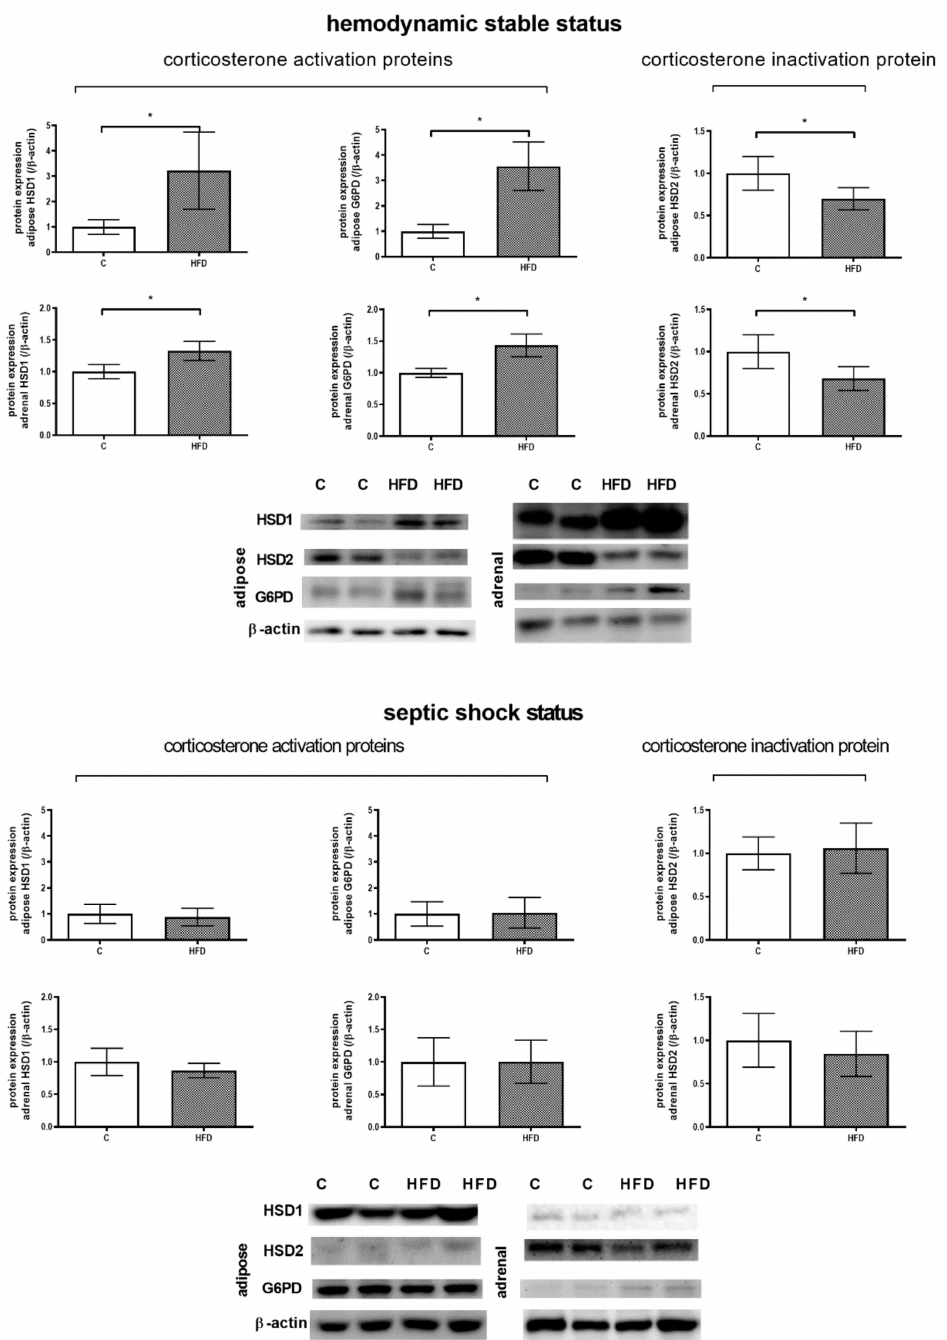
Figure 8. Adipose tissue and adrenal gland 11 β -HSDs system-related proteins expressions. ( A ) 11 β -HSD1, G6PD and 11 β -HSD2 protein expressions in hemodynamic stable condition. In the adipose tissue and adrenal gland, the expressions of 11 β -HSD1 and G6PD increased significantly whereas the expression of 11 β -HSD2 reduced. ( B ) 11 β -HSD1, G6PD and 11 β -HSD2 protein expressions in septic shock status. The 11 β -HSD system were not significantly di ff erent between the control and HFD groups. Taken together, the 11 β -HSD system tends to produce more corticosterone in HFD rats in usual hemodynamic stable status but lost this trend in sepsis. This explains, at least partly, the failure of the NAFLD rats to generate enough corticosterone to combat shock. (* p <